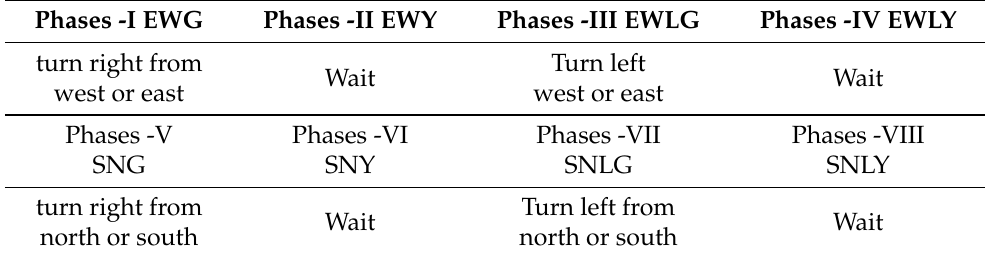
Table 1. Phase Scheme [25].